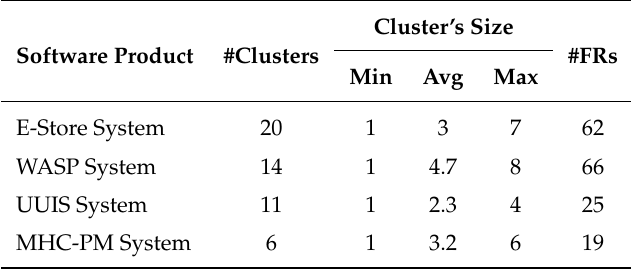
Table 1. Statistics on software products of